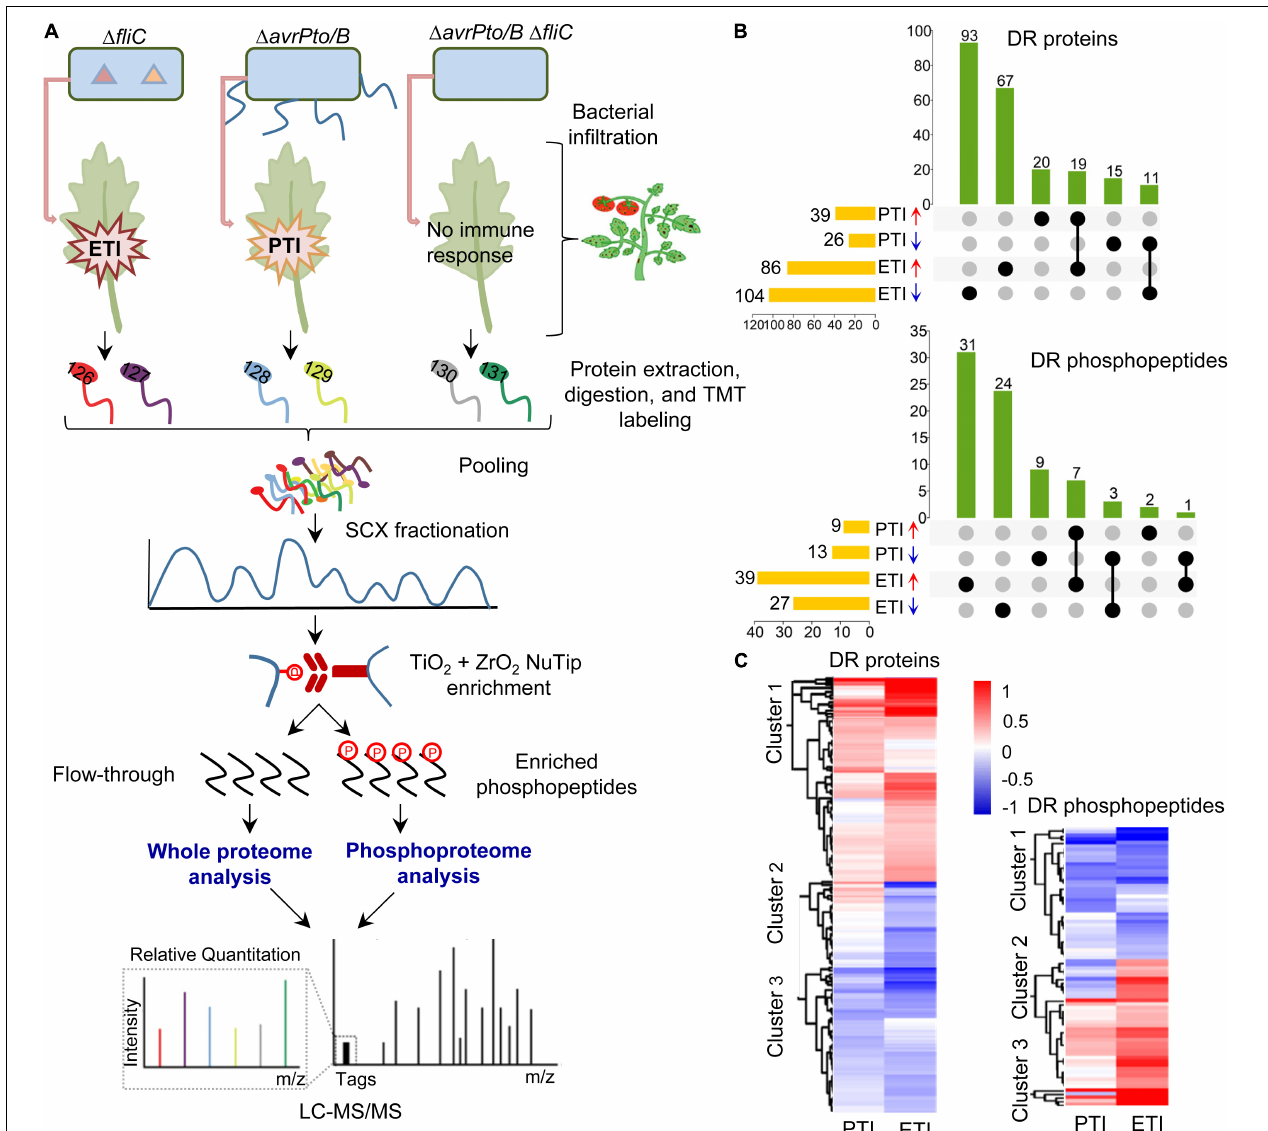
FIGURE 1 | Overview of the proteomics and phosphoproteomics workflow and summary of the tomato PTI and ETI results. (A) Workflow for the proteomic analysis. Four-week-old tomato leaves were vacuum infiltrated with different Pst DC3000 mutants. Proteins were extracted from leaf samples, digested by trypsin, and labeled with TMT reagents. After fractionation by strong cation exchange (SCX) chromatography, the phosphopeptides were enriched by TiO 2 + ZrO 2 NuTips, the flow-through and phosphopeptides were submitted to reverse phase liquid chromatography tandem mass spectrometry (LC-MS/MS), and analyzed with Proteome Discoverer 2.4 software and bioinformatic tools; (B) Upset plot displaying the overlaps of differentially regulated (DR) proteins and phosphopeptides during PTI and ETI. Each column represents shared DR proteins/phosphopeptides among the comparisons (dots connected by lines below the X axis), with the comparisons on the left and the total number of DR proteins/phosphopeptides. The number of DR proteins/phosphopeptides in each set is shown on the top of the column; and (C) Hierarchical clustering analysis of DR proteins and phosphopeptides. The two columns represent different treatments of PTI and ETI. The rows represent individual proteins/phosphopeptides. The detailed information is listed in Supplementary Tables 4, 5 . The increased or decreased proteins/phosphopeptides are indicated in red or blue,